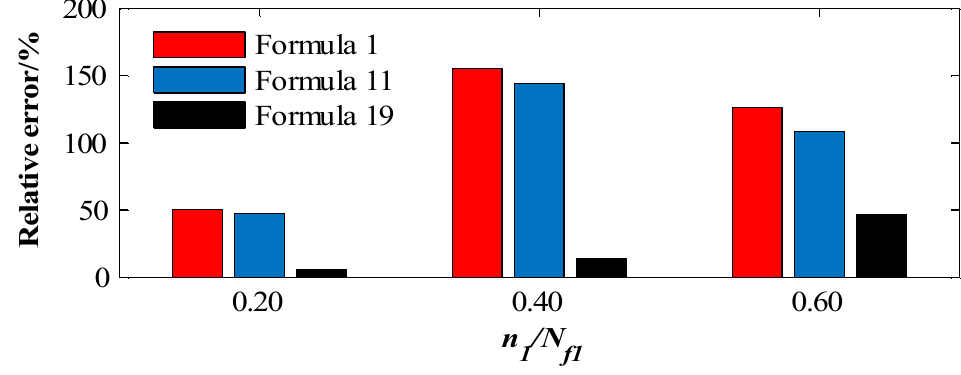
Figure 13. (200–150 MPa) The relative error of each model under different n 1 /N f 1 (Al-2024).